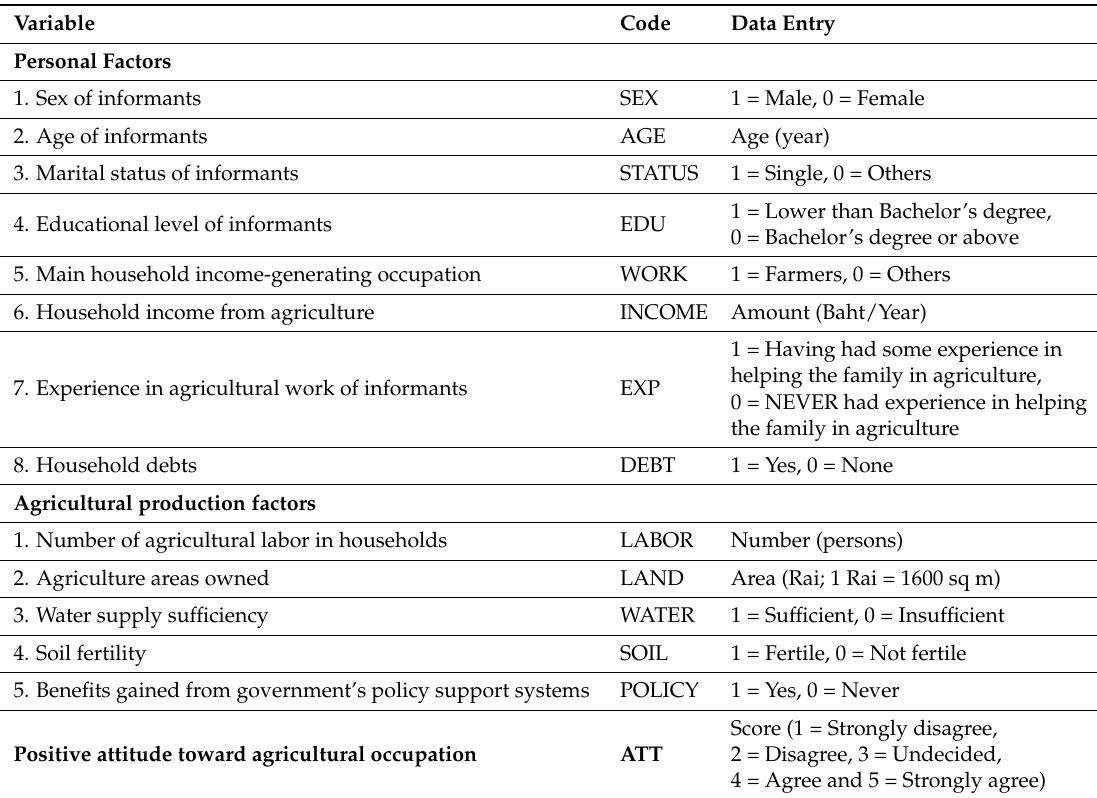
Table 1. Independent variables used in testing the